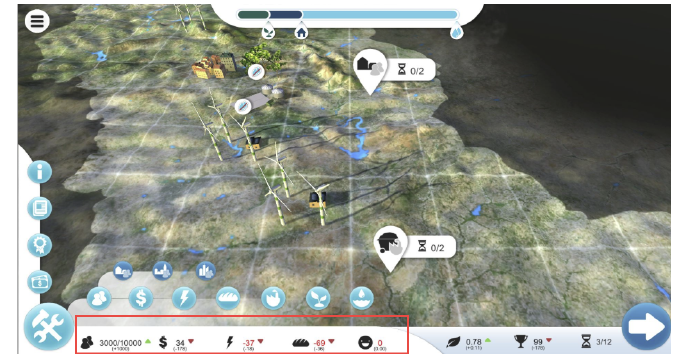
Fig. 4. Five factors to calculate the basin